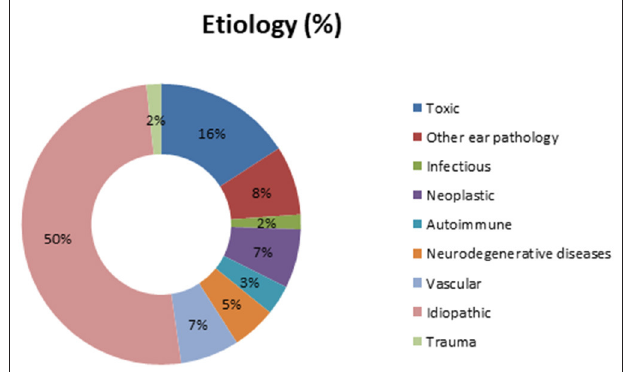
FIGURE 1 | Distribution of etiologies in the study’s population.